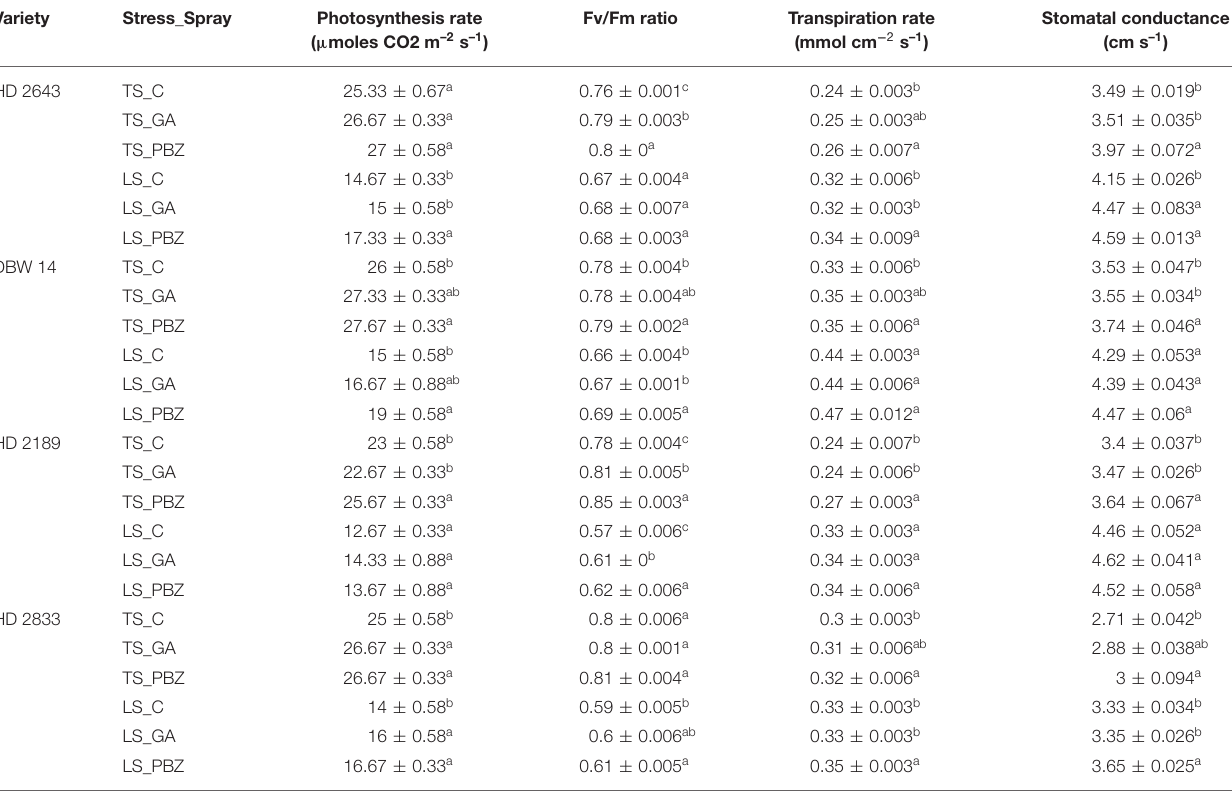
TABLE 2 | Effect of post-anthesis application of gibberellic acid (100 ppm) and paclobutrazol (50 ppm) on photosynthesis rate ( µ moles CO 2 m − 2 s − 1 ), Fv/Fm ratio, transpiration rate (mmol cm − 2 s − 1 ), and stomatal Conductance (cm s − 1 ) in wheat exposed to timely and late sown conditions.